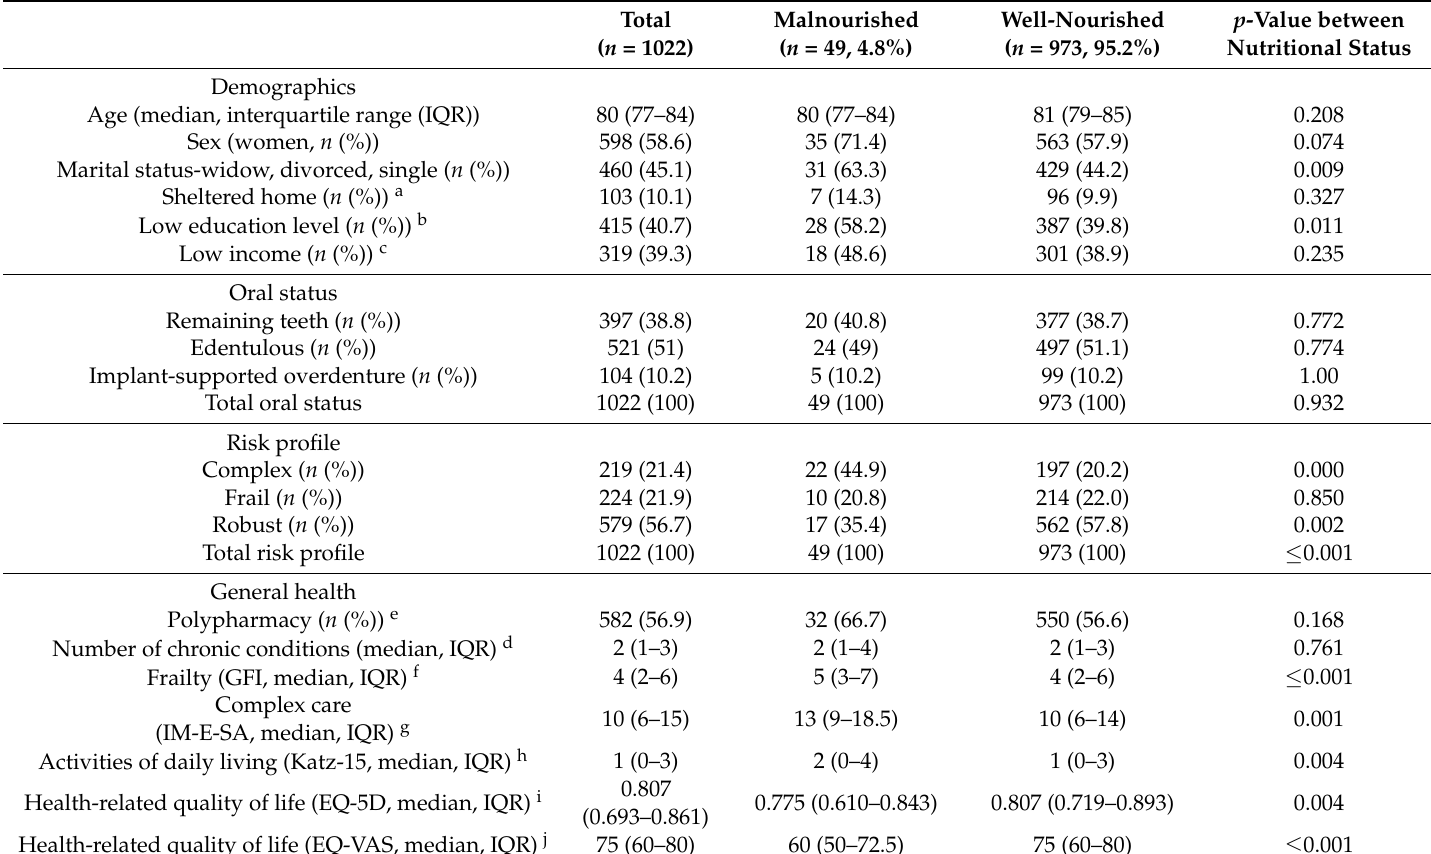
Table 1. Nutritional status and